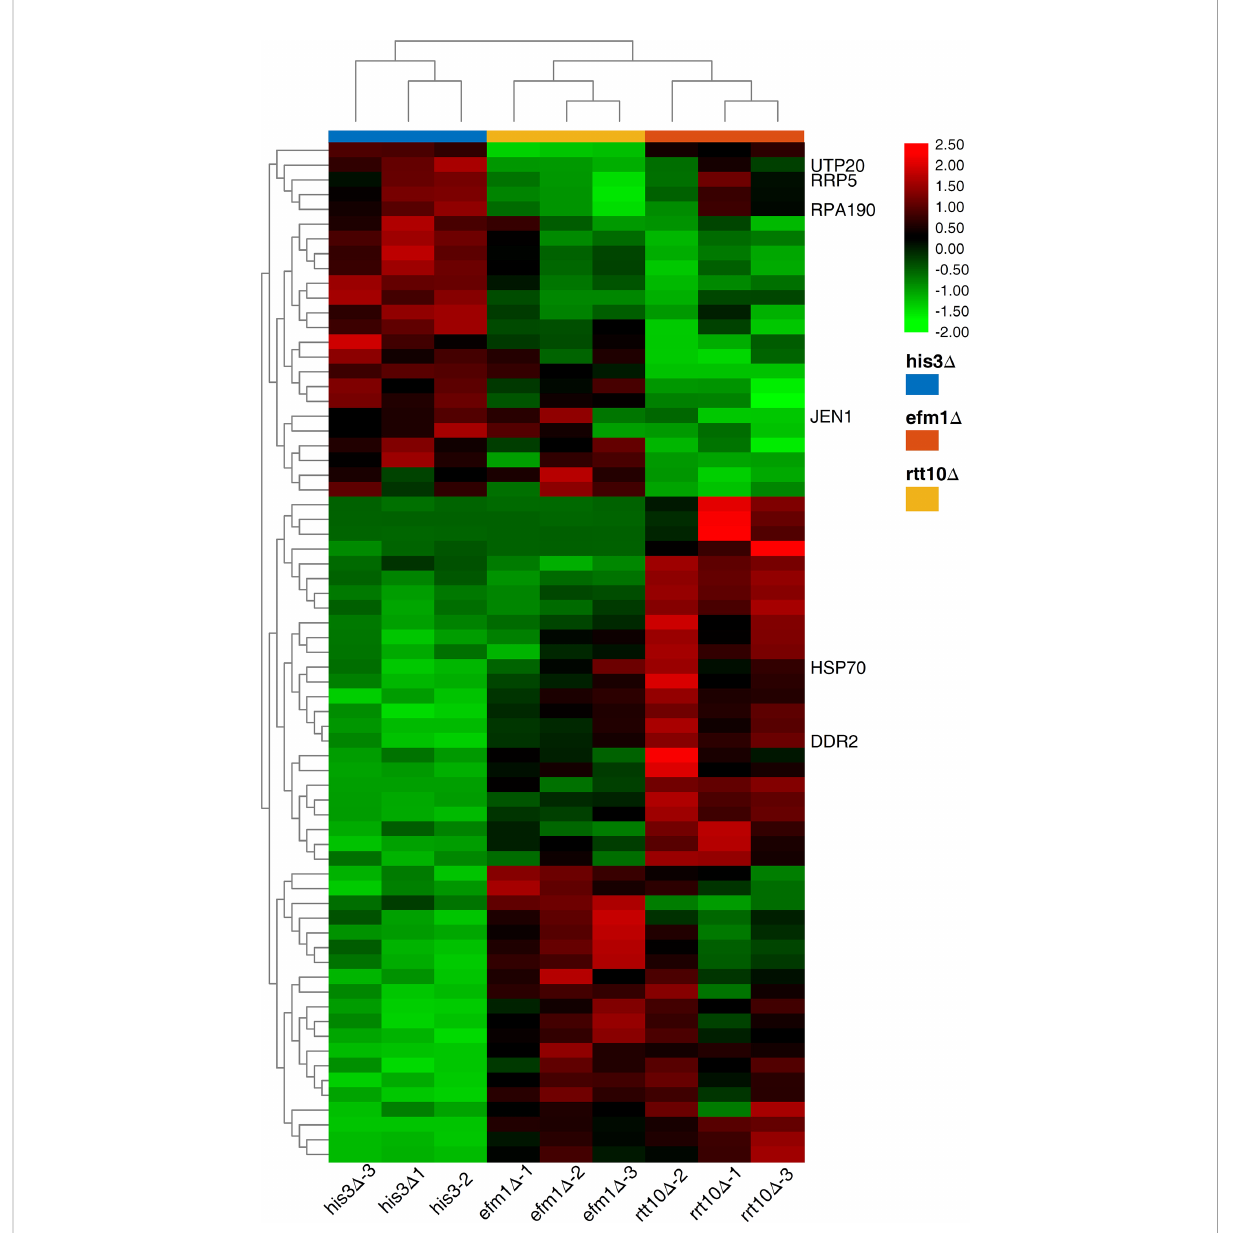
FIGURE 6 Heat map of DEGs expression in His D 3, efm1 D , rtt10 D strains. The expression patterns of DDR2, HSP70, JEN1, UTP20, RPA190 and RRP5 genes were marked. The color scale indicates the relative expression